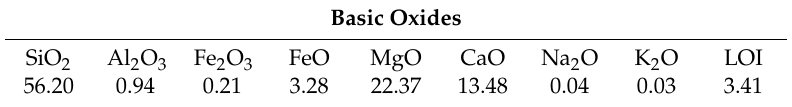
Table 1. Chemical composition of low grade nephrite, mass%.